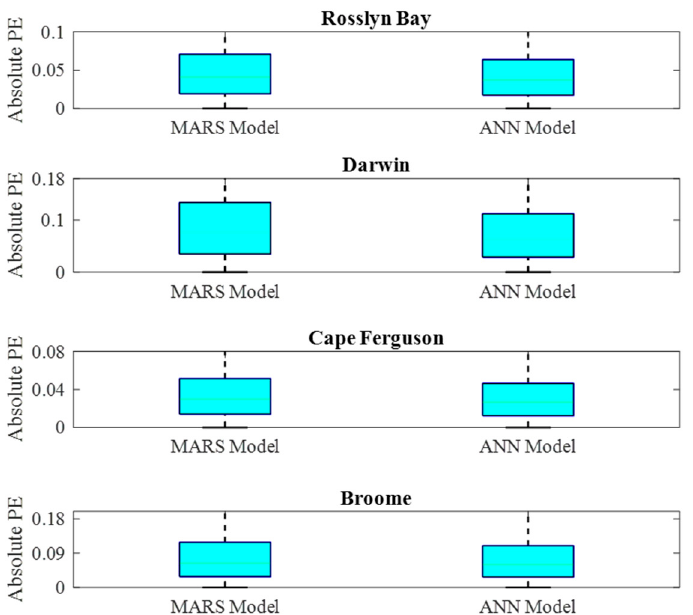
Figure 8. Boxplots show the absolute prediction error distribution of the MARS and ANN model.